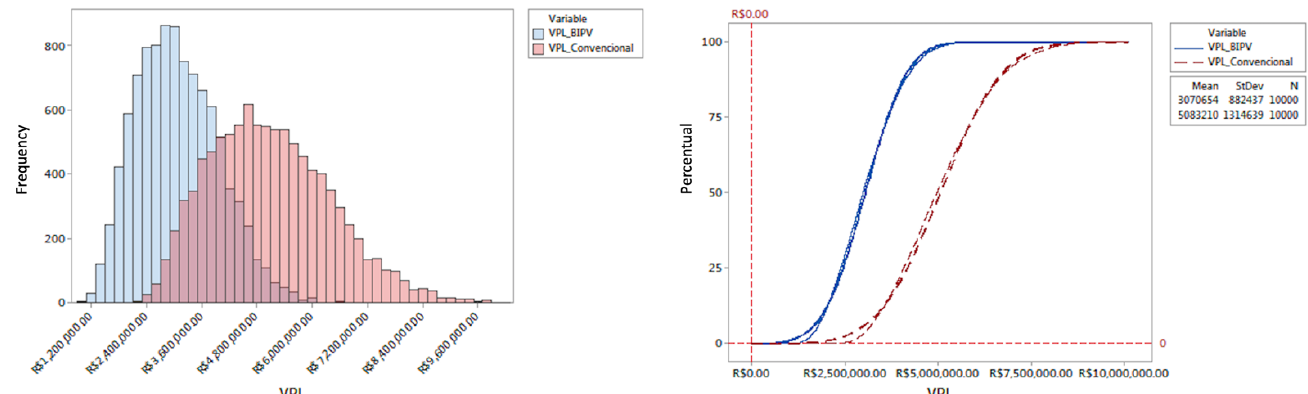
Table 8. Results of stochastic simulations of NPV for the municipality of Pau dos Ferros-RN.